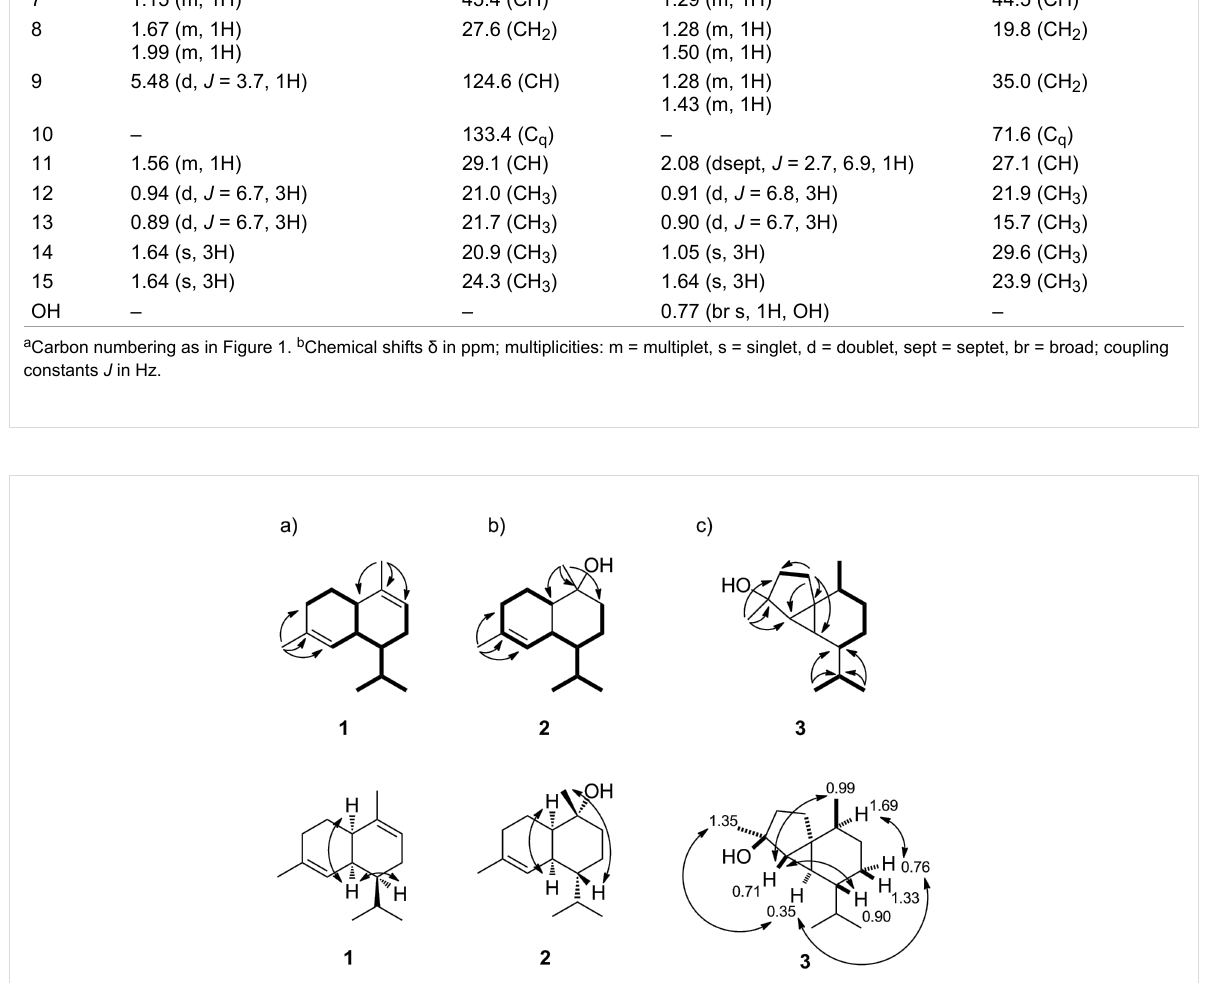
homology are encoded in more than 40 genome sequenced streptomycetes that all show an altered NSE triad starting with either proline or alanine. The closest relative of the enzyme from S. viridochromogenes is found in Streptomyces sp. NRRL S-481 (86%